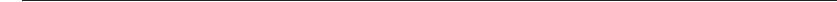
Table 3. The results of virtual screening of drugs on the active sites of SARS-CoV-2 3CL pro model. The left and right columns are the results of A and B chains, respectively. The top scorers are listed first, then the equivalent top scorers of the other chain listed at the lower half. ‘M.W.’: molecular weight in g mol -1 . ‘B.E.’: AutoDock Vina binding energy in kcal mol -1 . The ‘Hits’ column is the number of times a compound appears as top scorers (representing different stereoisomers) out of the total number of stereoisomers of that compound in the library; only the binding energy of the top-ranking hit was shown. Etoposide and its phosphate are listed separately in the screens. ‘n.f.’ = not found. Approved and pre- approved drugs are shown in green and orange, respectively. Except dihydroergocristine and ditercalinium, all approved drugs have undergone post-market surveillance, i.e. Phase 4. The mean score of each screen (1500 results), scores of lopinavir and ritonavir are included at the bottom for reference. A Chain B Chain